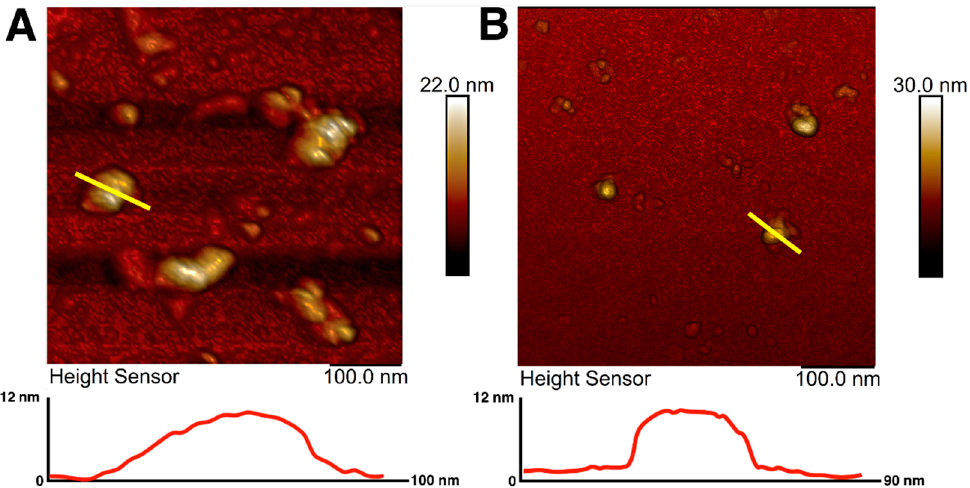
Figure 1. AFM images and surface profiles of magnetic nanoparticles without citrate ions stabilization ( А ) and with citrate ion stabilization ( B ). The yellow line shows the surface profile.